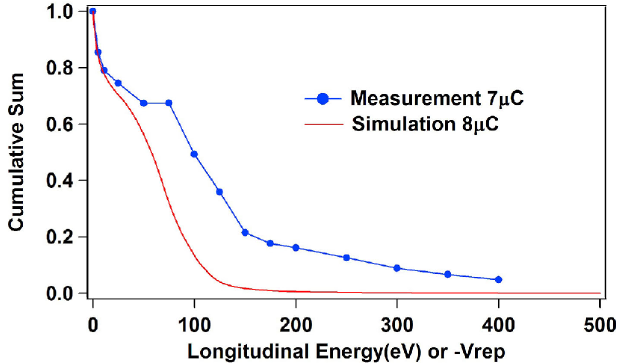
FIG. 11. (Color) Prompt electron longitudinal cumulative en- ergy spectrum from the quadrupole diagnostic for a beam intensity of 7 (cid:1) C = pulse compared with simulation results for a beam intensity of 8 (cid:1) C = pulse . The abscissa for the measured distribution is (cid:5) Vrep (repeller voltage) and the curve is normal- ized to 1 at Vrep (cid:7) 0